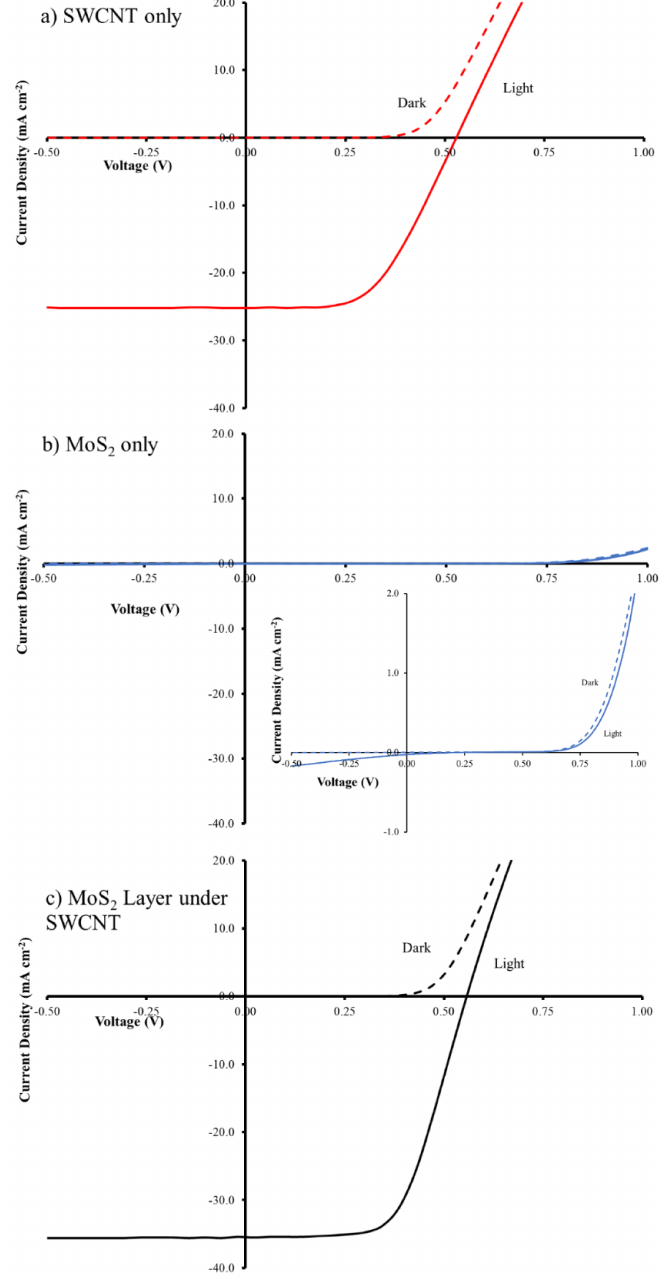
Figure 3. J-V curves of ( a ) SWCNT/n-Si; ( b ) MoS 2 /n-Si and ( c ) SWCNT/MoS 2 /n-Si solar cells. Inset in ( b ) show an expanded view of the J-V curves for MoS 2 /n-Si